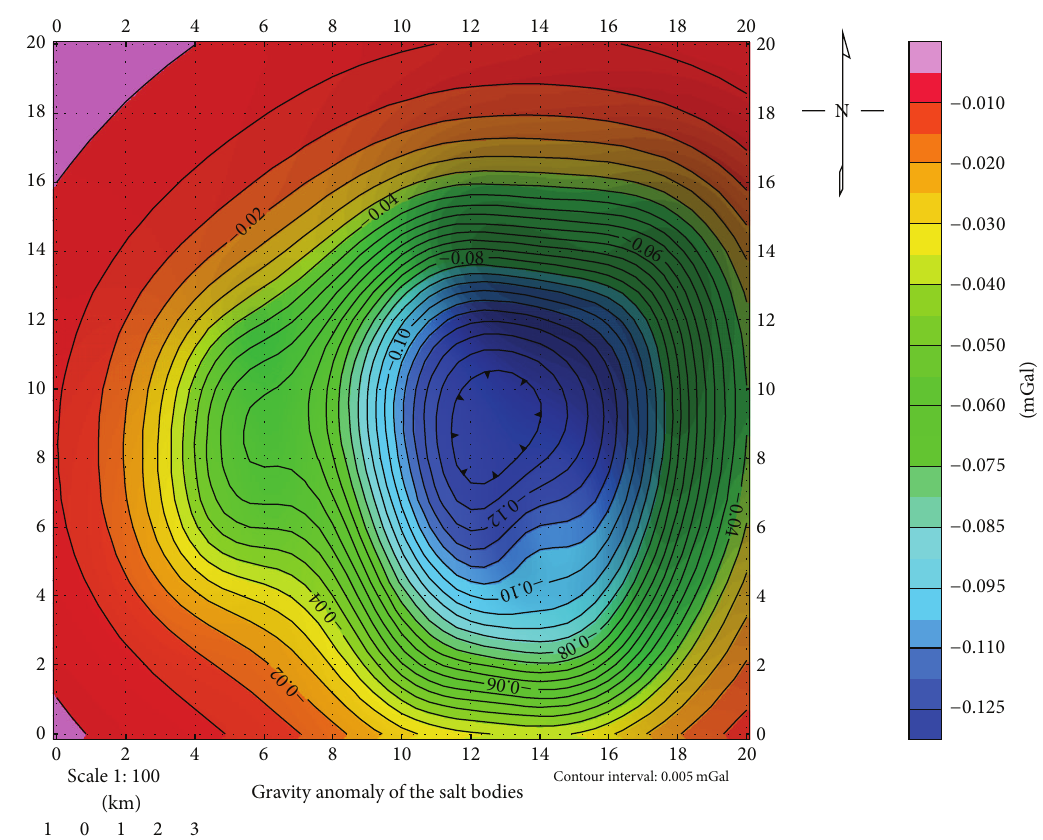
Figure 4: Gravity anomaly caused by the salt bodies depicted in Figure